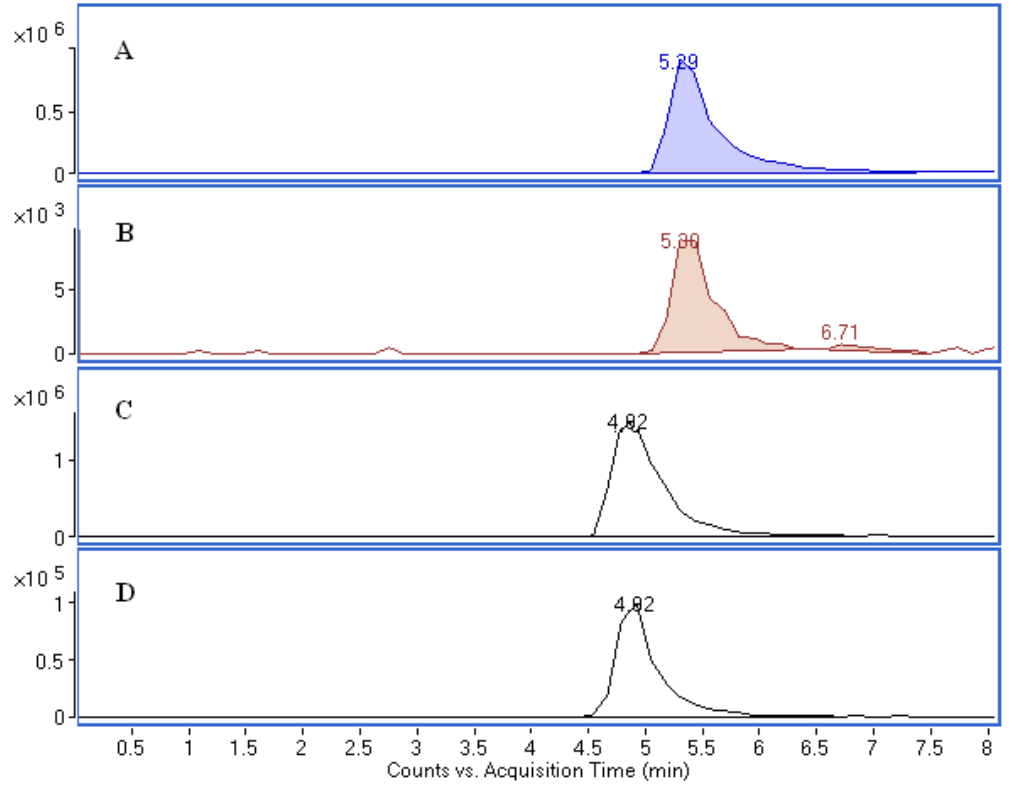
Figure 10. Main fragmentation pathways of compound 1 and compound 2